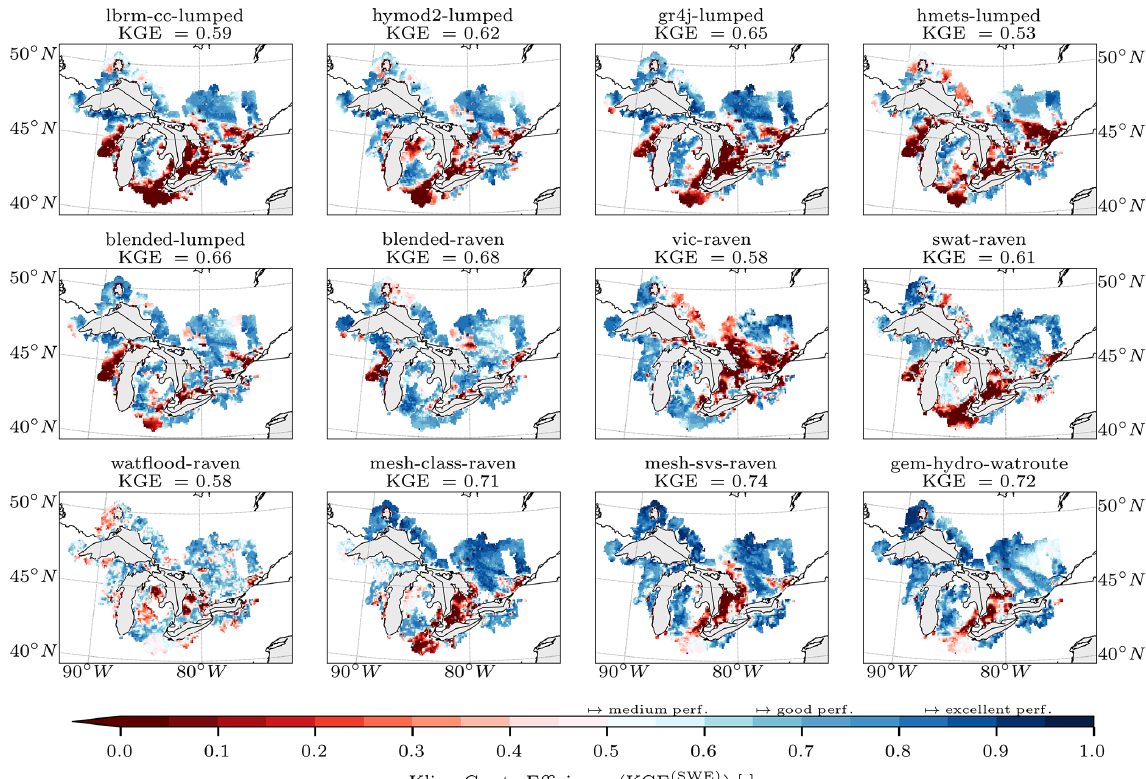
Figure 7. Grid-cell-based model performance regarding snow water equivalent. The performance of 12 models (panels) regarding snow water equivalent (SWE) is shown. The model outputs are regridded to the grid of the reference dataset (here ERA5-Land; variable sd ). Only grid cells that are available in the reference dataset and all 12 models are displayed (6174 grid cells in total) and used to derive the Kling–Gupta efficiency (KGE) values based on all available observations larger than 1mm of daily SWE between January 2001 and December 2017. The median KGE across space is added as a label at the top of each panel. The color bar has labels added to categorize the performance into medium, good, and excellent. The machine-learning-based LSTM model is not displayed, as this is the only model not simulating snow water equivalent